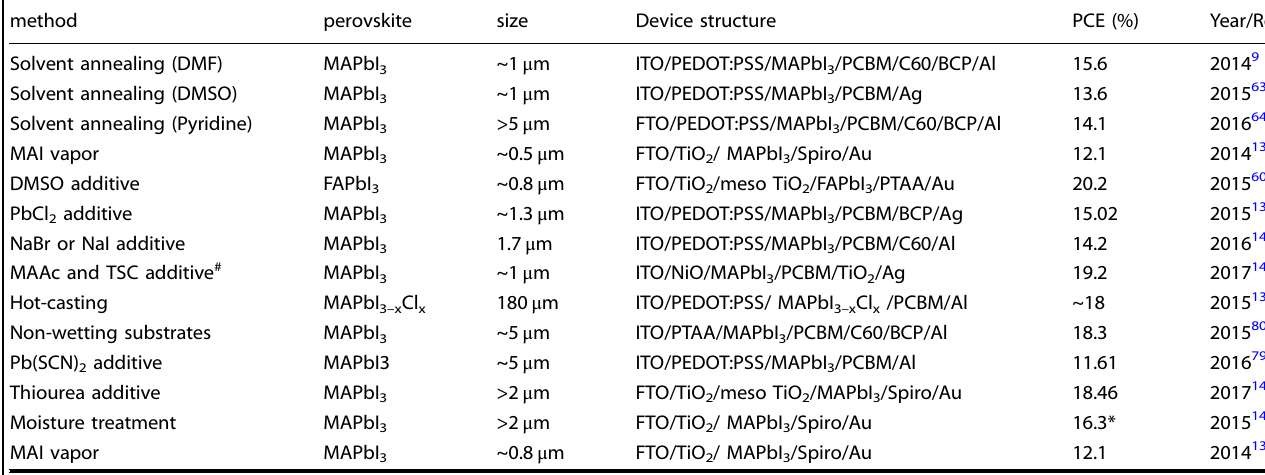
Table 1. Summary of enlarging perovskite grain size and the related highest PCE of devices